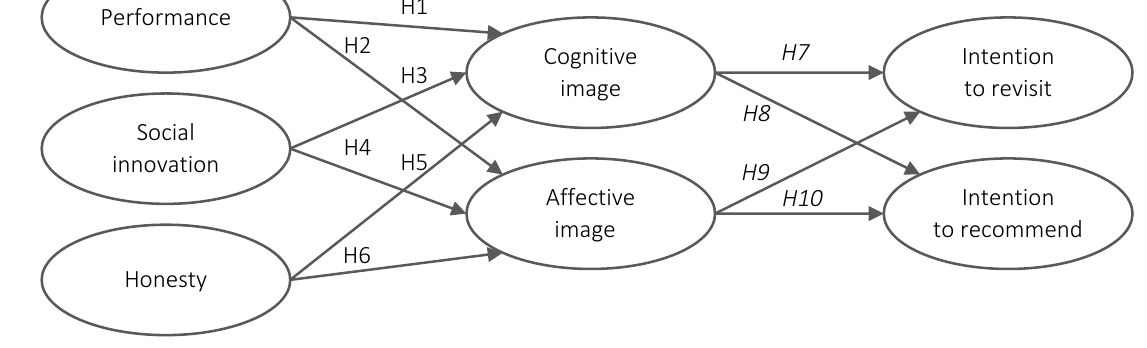
Figure 1. Theoretical